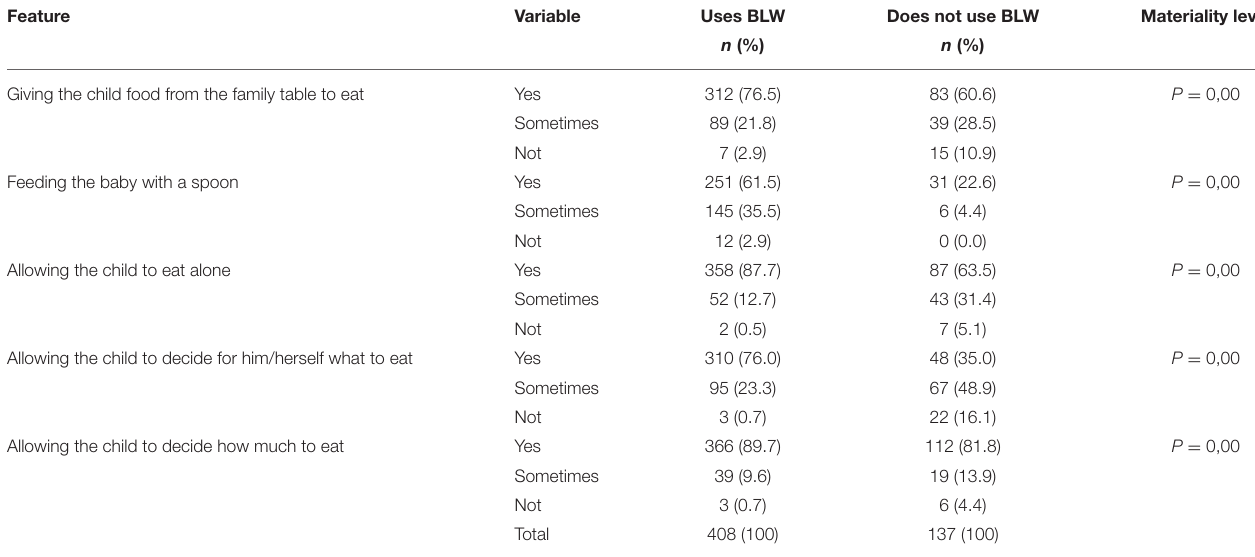
TABLE 9 | Assumptions of the BLW method used and not used in the group of mothers declaring and not declaring to use the BLW method. Feature Variable Uses BLW Does not use BLW Materiality